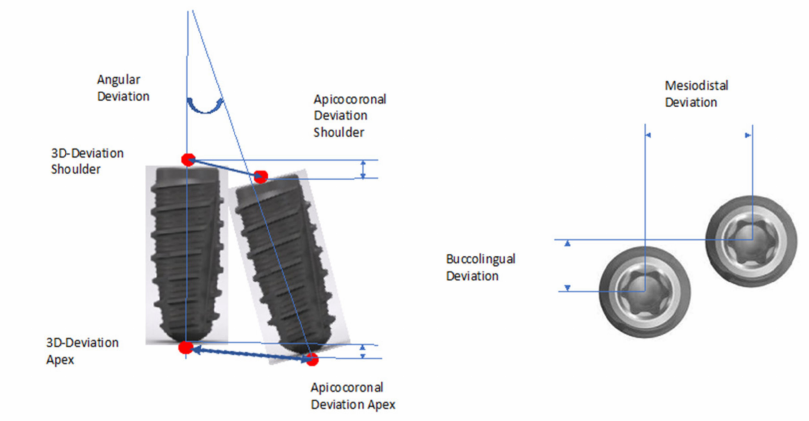
Figure 1. Representation of the measuring distances and the angular deviation between the planned and actual achieved implant